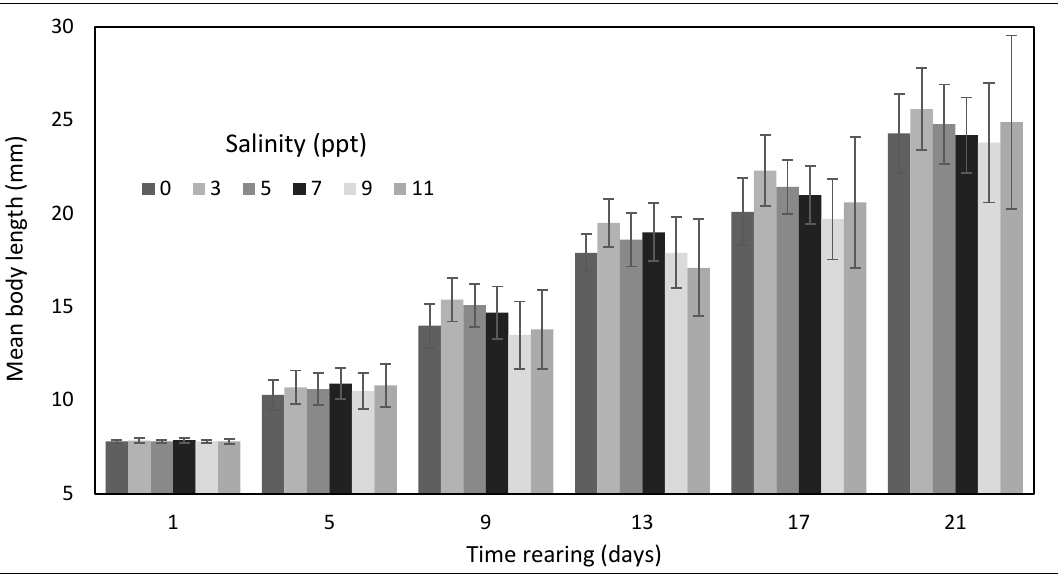
Figure 2. Average total body length increases in asp larvae Leuciscus aspius (L.) reared in water with various salinity levels.